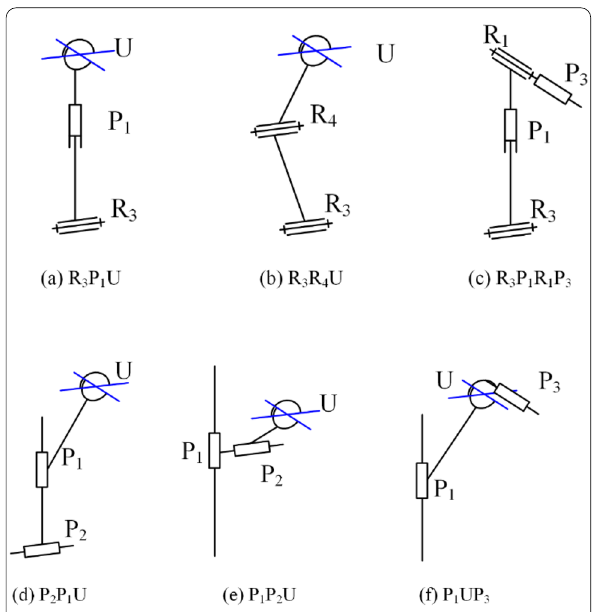
Figure 6 Six types of branch with four single joints in Case